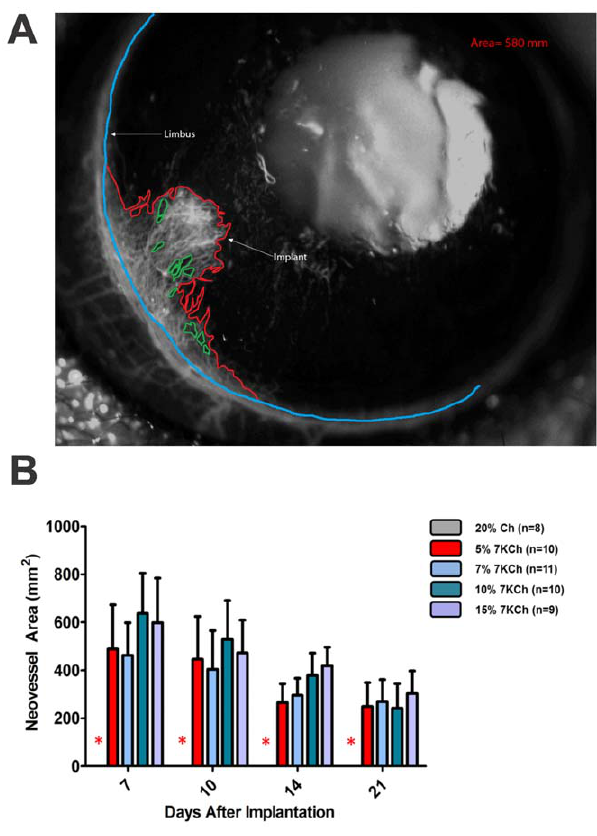
Figure 4. Technique used to quantify neovessel formation. Vessels were imaged using a fluorescent dissecting microscope immediately after IP injection of fluorescein as described in Methods. A. Neovessel area was quantified using Nikon NIS elements hands free tool by delineating the base of neovessels (blue line), the border of the neovessels (red line) and subtracting areas with no vessels (green line). B. Graph showing neovessel area from the experiments described in Fig. 3 in mm 2 .